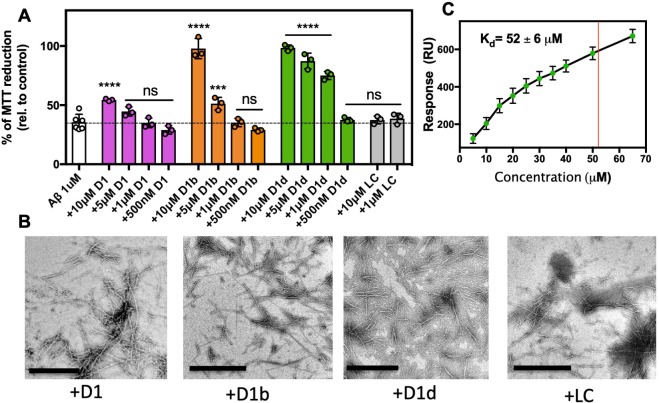
Inhibitors bind and block toxicity of aggregated Aβ1–42.(A) The toxicity of already formed Aβ1–42 aggregates is lessened by peptide inhibitors. 10 μM Aβ1–42 was incubated alone for 12 hr at 37°C. Indicated molar ratio of inhibitor was added to the incubated Aβ1–42 and then diluted 1:10 with pre-plated N2a cells. Cytotoxicity was quantified using MTT dye reduction. Bars represent mean with individual technical replicates (n = 3–6; ns = not significant; ***, p<0.0005; ****, p<0.0001 using an ordinary one-way ANOVA- Dunnett’s relative to leftmost column). (B, C) Inhibitors bind to Aβ1–42 fibrils. (B) Peptide inhibitors do not disaggregate Aβ. 10 μM Aβ1–42 was incubated alone for 72 hr at 37 °C. Peptide inhibitors were added at 10-fold molar excess and incubated at RT for 24 hr before TEM analysis. Images were captured at 24,000x; scale bars are 500 nm. (C) Binding isotherm of inhibitor D1d to fibrillar Aβ1–42. The maximal response (RUmax) was derived by fitting sensorgrams obtained over a range of D1d concentrations to the binding model with a Kd of 52 ± 6 μM, displayed as a red line. These RUmax values are plotted (mean ± SD, n = 3) as a function of concentration and fitted to a one-to-one binding model, displayed as a black line.10.7554/eLife.46924.016Figure 4—source data 1.Toxicity data points—Aβ aggregates treated with inhibitors.